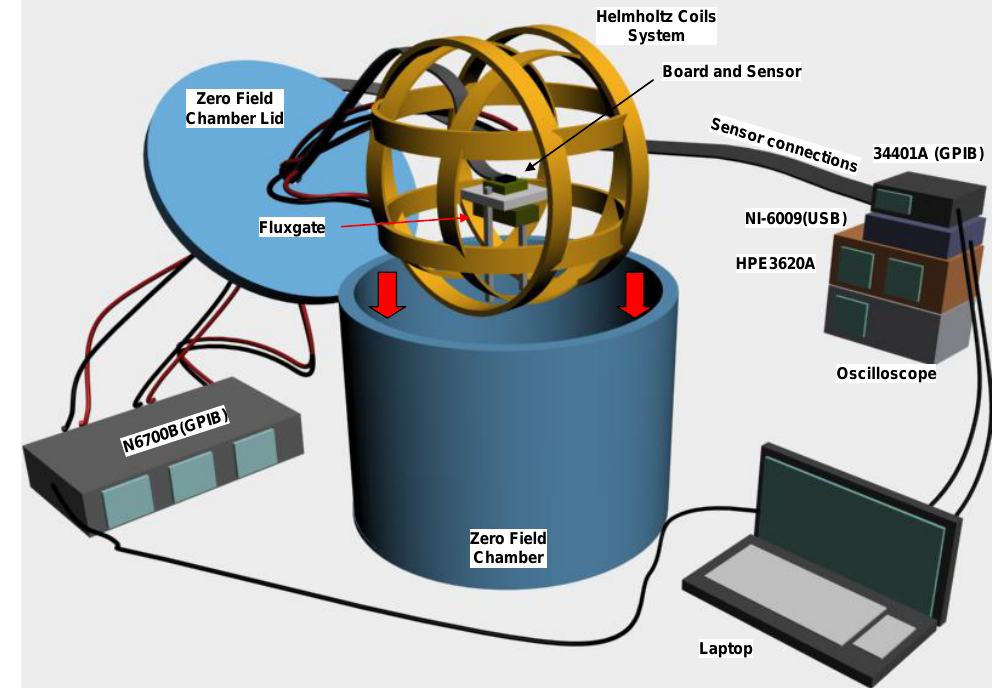
Figure 3. Sketch of the measurement set-up. Types of computer connections are indicated in